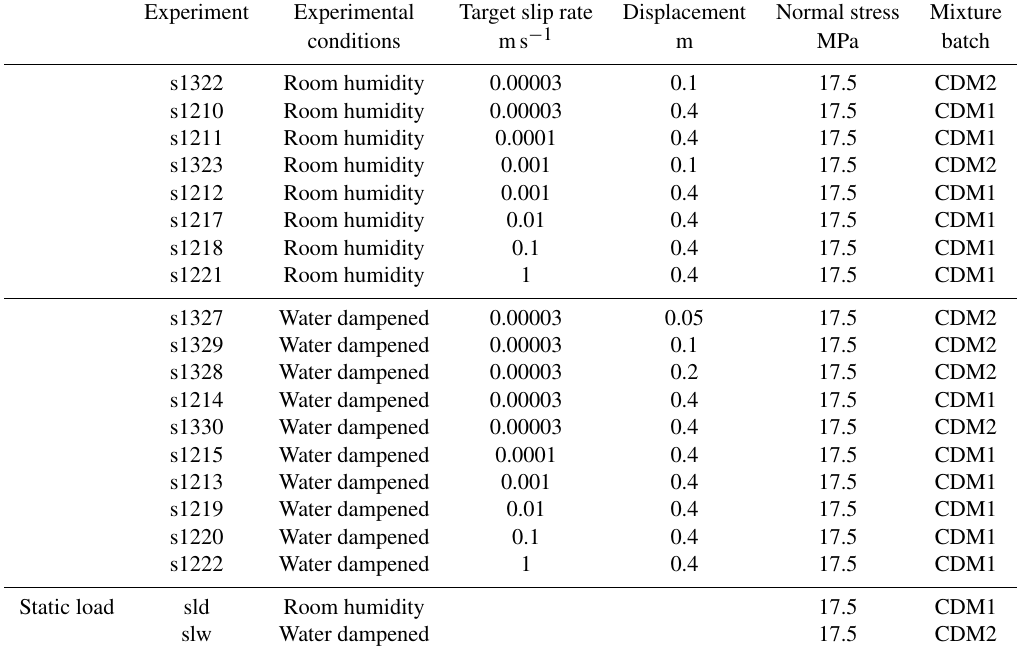
Table 1. Experiments reported in this study.